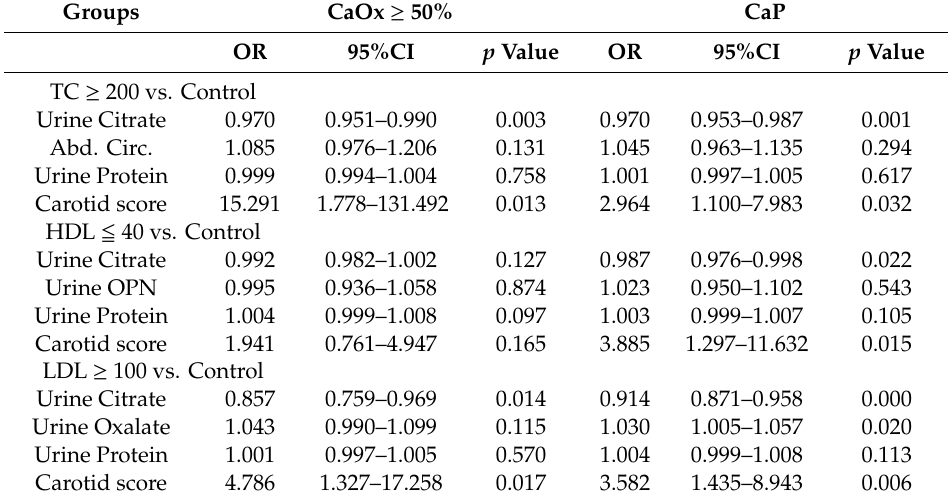
Table 4. Risk factors in each stone group compared to the controls, using a logistic regression with abnormal serum cholesterol levels (adjusted by age and